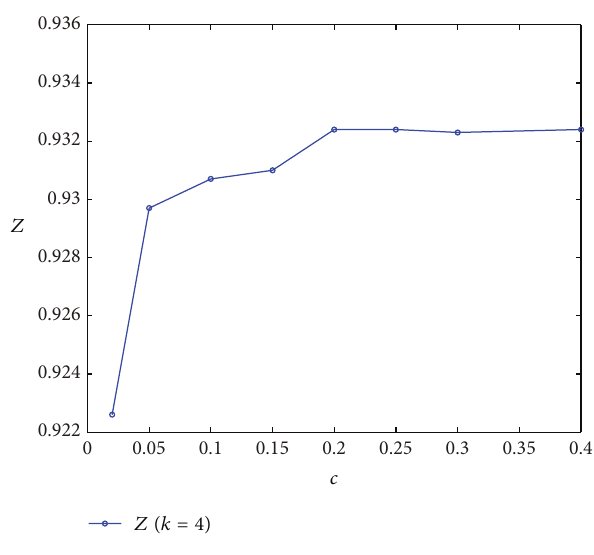
Figure 7: Curve of 𝑍 varied with 𝑐